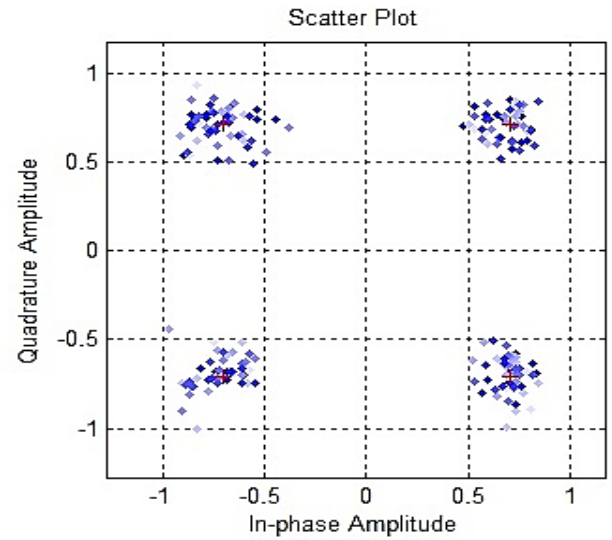
Figure 4: QPSK constellation for classical DCR